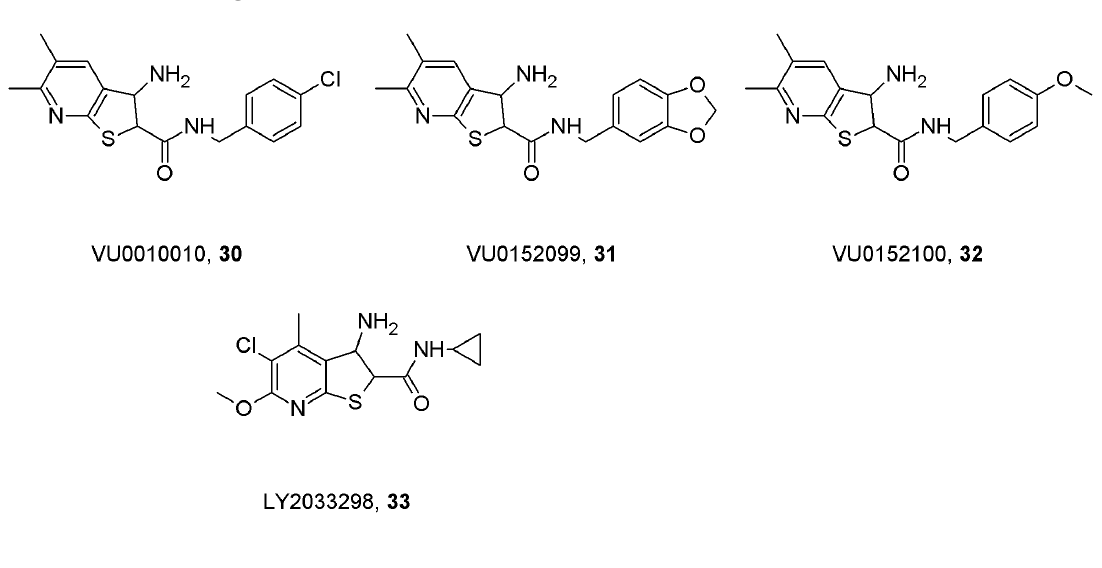
Figure 9. Structure of M